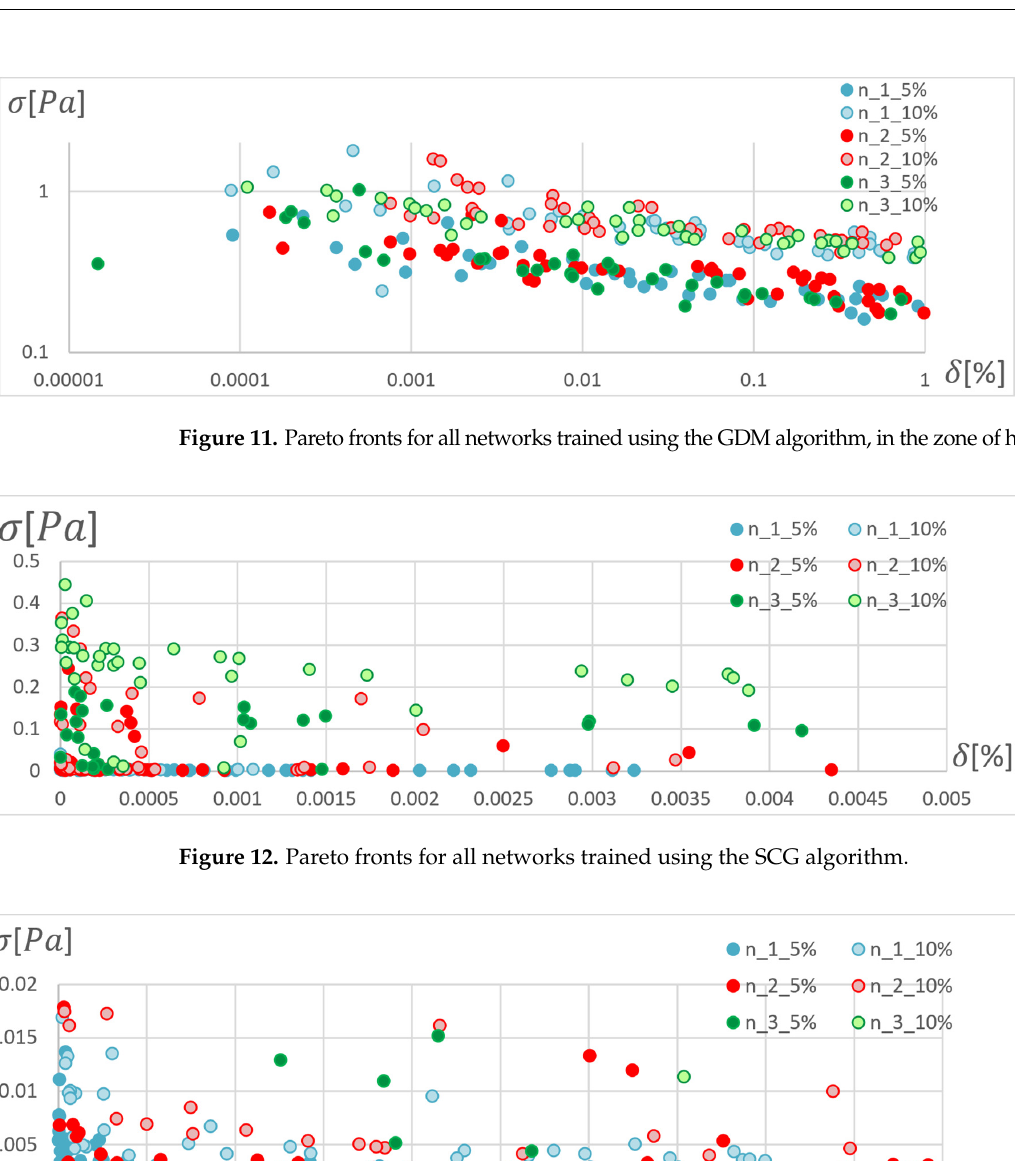
Figure 10. Pareto fronts for all networks trained using the GDM algorithm.